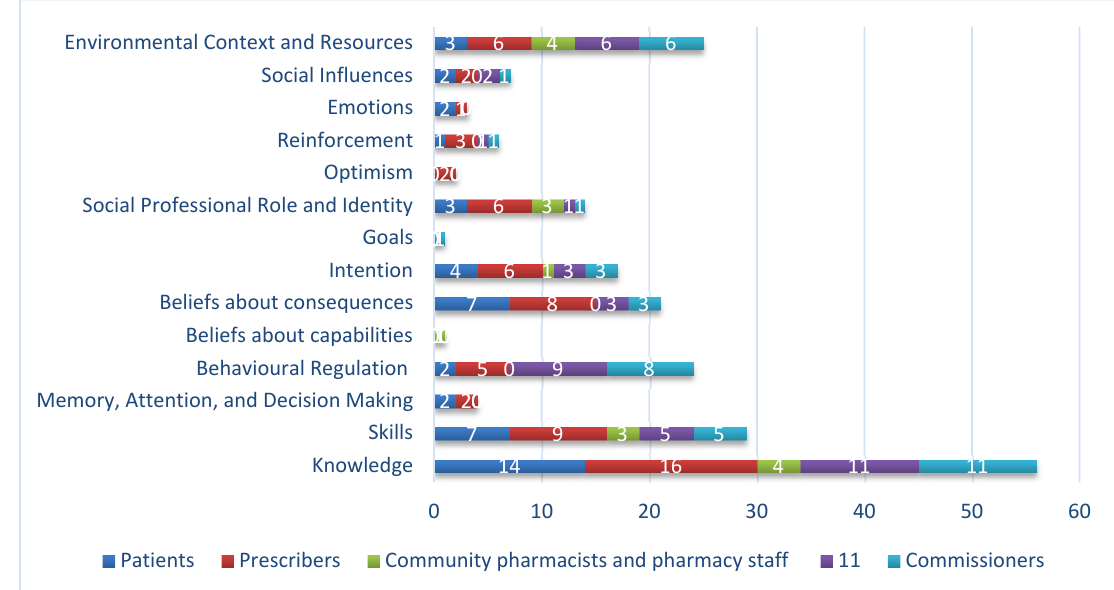
Figure 4. Influences (Capability, Opportunity, Motivation–Behavior (COM-B)) on behavior targeted in interventions, by target group.